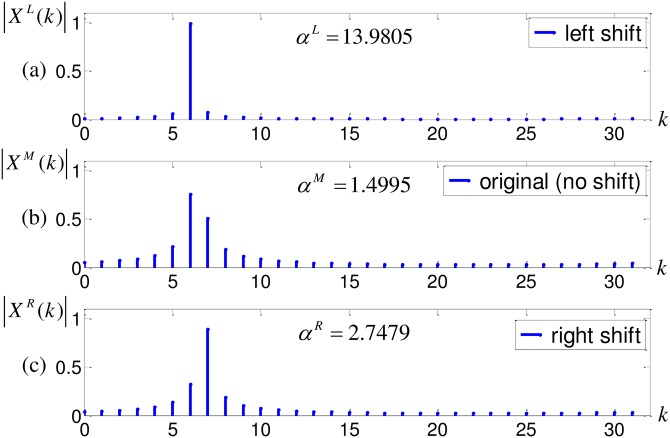
DFT spectra of different frequency shift cases.